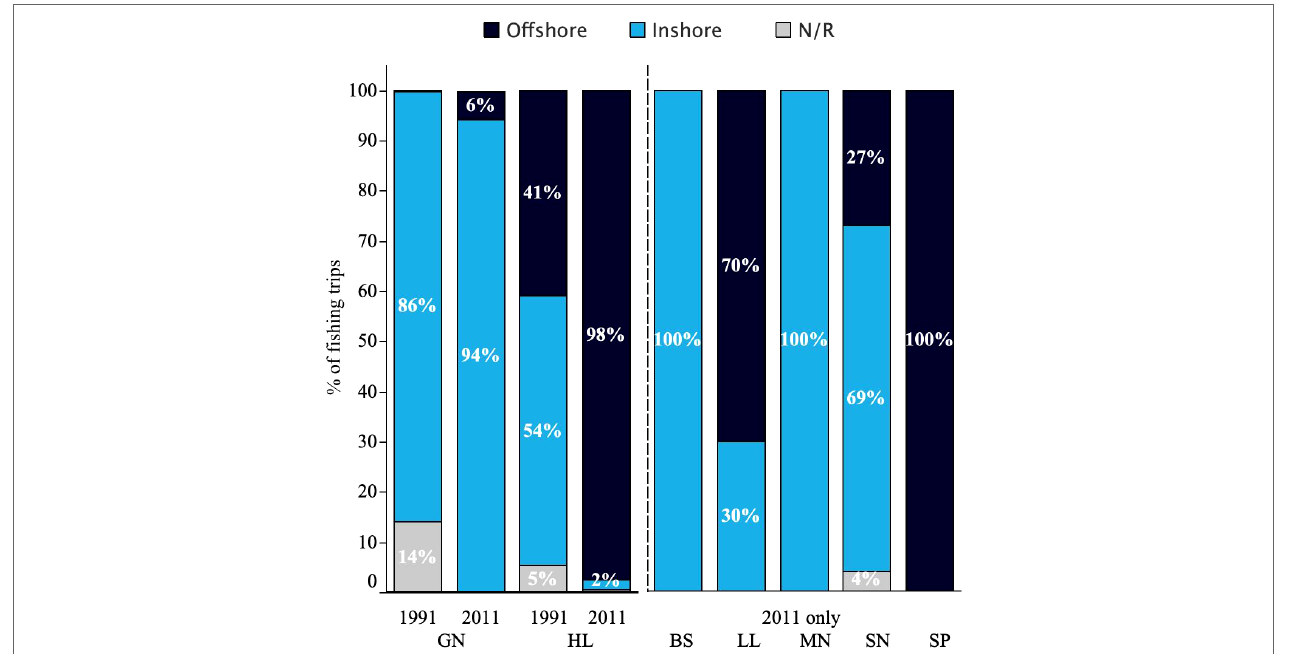
FIGURE 2 | Proportional location of deployments of each gear in 1991 (Laroche et al., 1997) and 2011, this study (N/R, location not recorded; Gears, GN, gillnet; HL, handline; BS, beach seine; LL, longline; MN, mosquito net; SN, shark net; and SP, spear/speargun) by each location type. Temporal comparison (left) shown only for gillnet and handlines as other gears were not reported as being used in